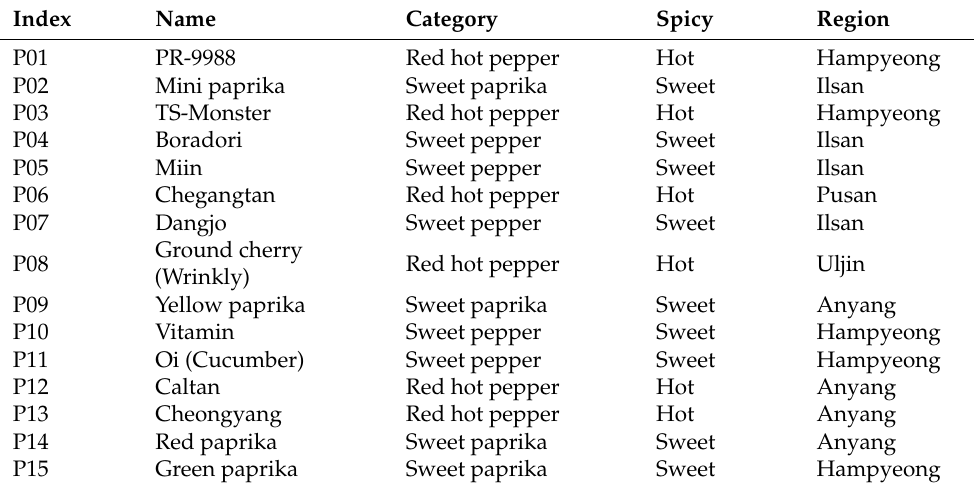
Table 1. Summary of pepper cultivars used for virome study. A total of 15 different pepper cultivars derived from 5 nurseries indicated by region, were used for the virome study. Pepper cultivars were divided into three categories: red hot pepper, sweet pepper, and sweet